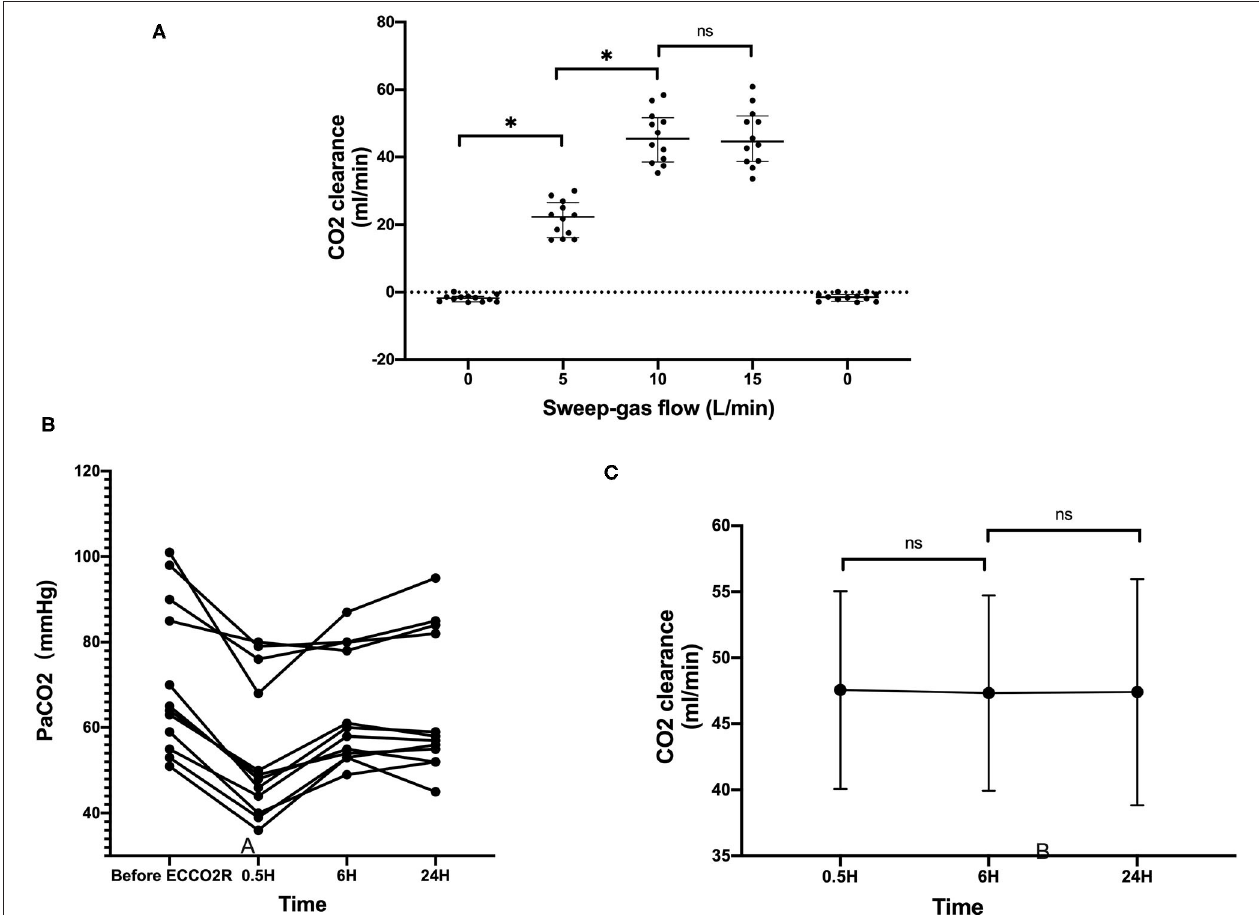
FIGURE 3 | The CO 2 clearance with the ECCO 2 R. (A) The CO 2 clearance rate at different levels of sweep-gas flow. (B) The PaCO 2 levels of all the 12 patients before and after the ECCO 2 R. (C) The CO 2 clearance rate with time * p < 0.05; ns, no statistical